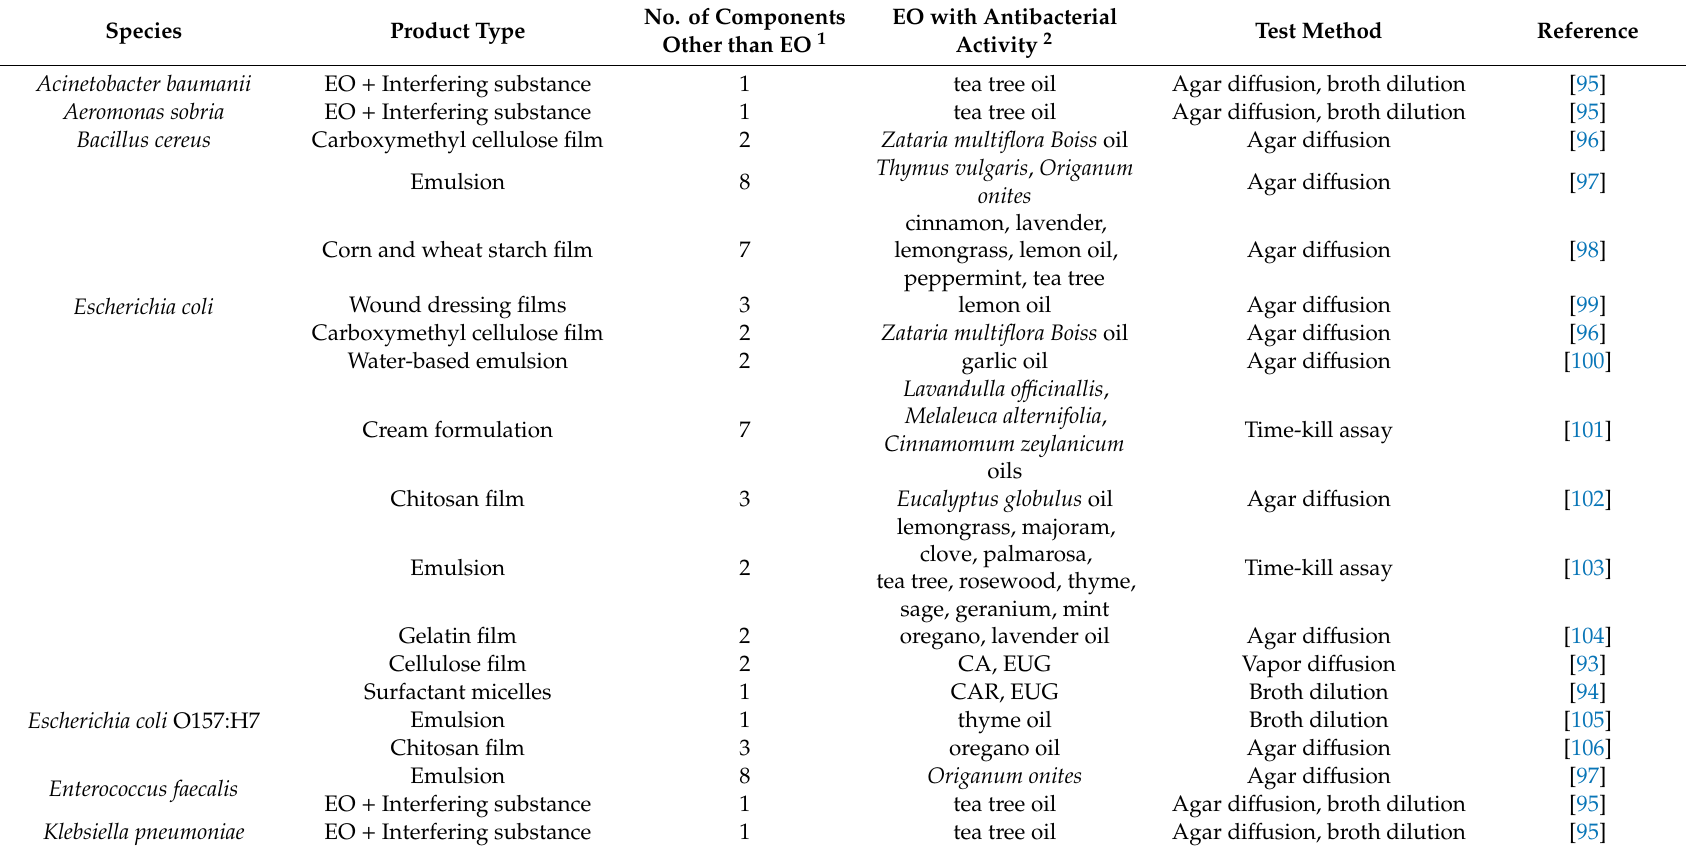
Table 5. Major ingredients and antibacterial e ffi cacy of EO-based disinfectant